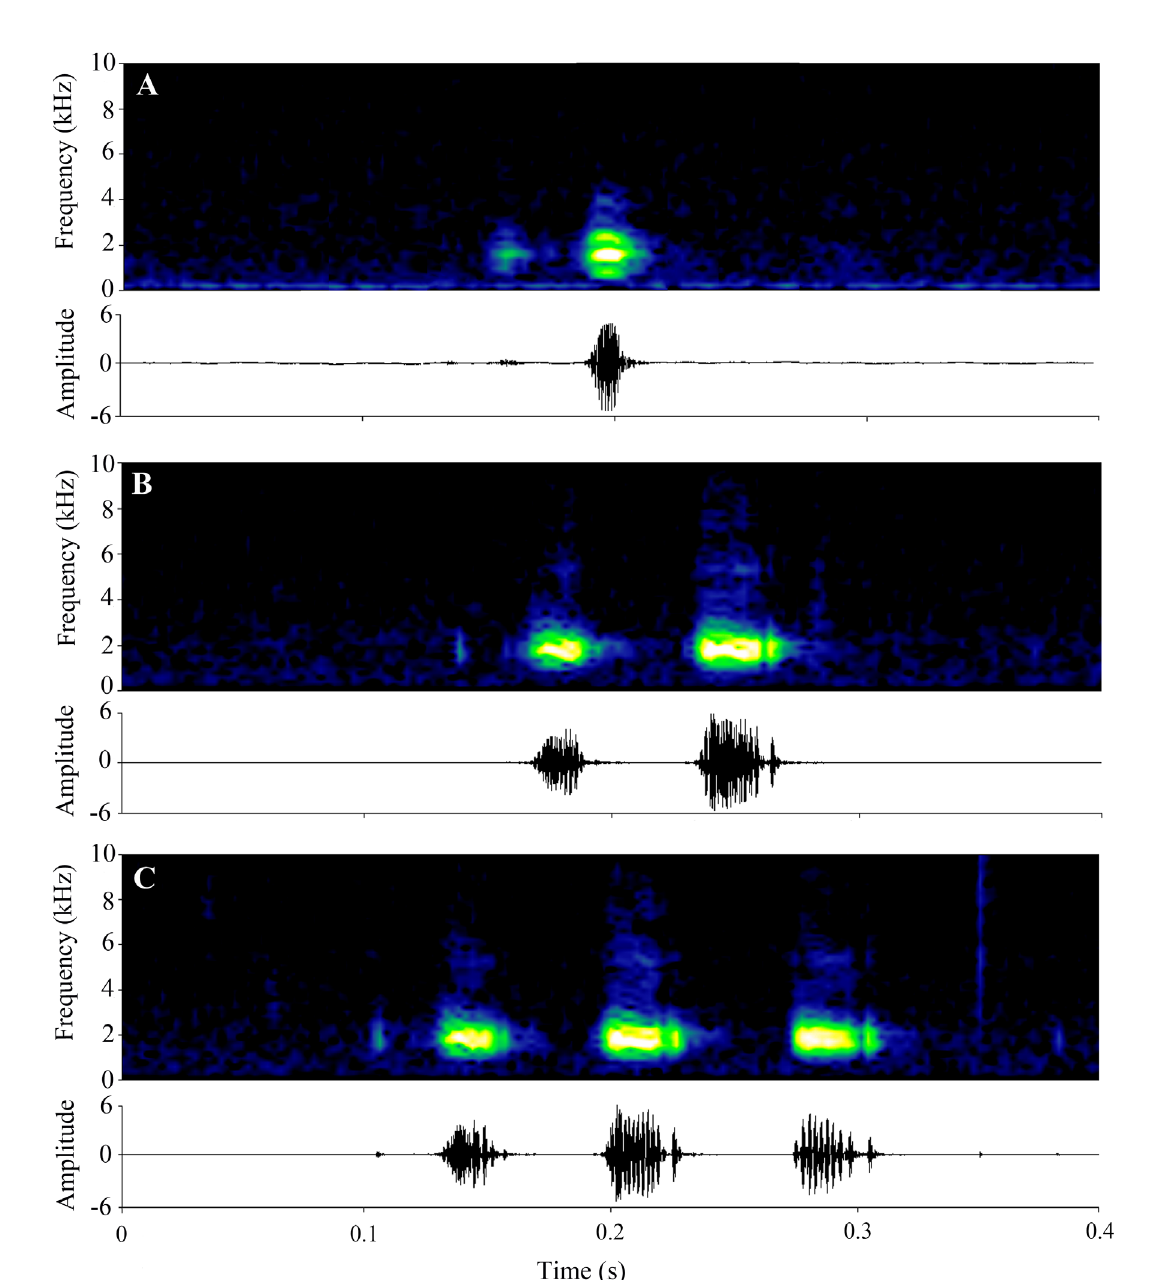
Fig. 4. Spectrograms (above) and oscillograms (below) of advertisement calls of Physalaemus araxa sp. nov., highlighting an increasing complexity with one ( A ), two ( B ), or three ( C ) notes; recorded in the Caparaó National Park, municipality of Ibitirama, state of Espírito Santo,